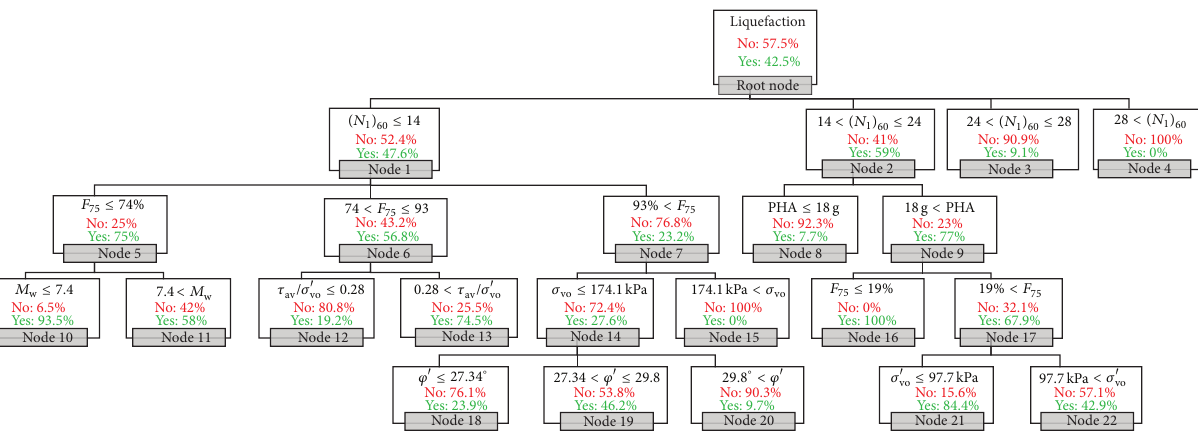
Figure 3: Final CHAID-SPT tree.